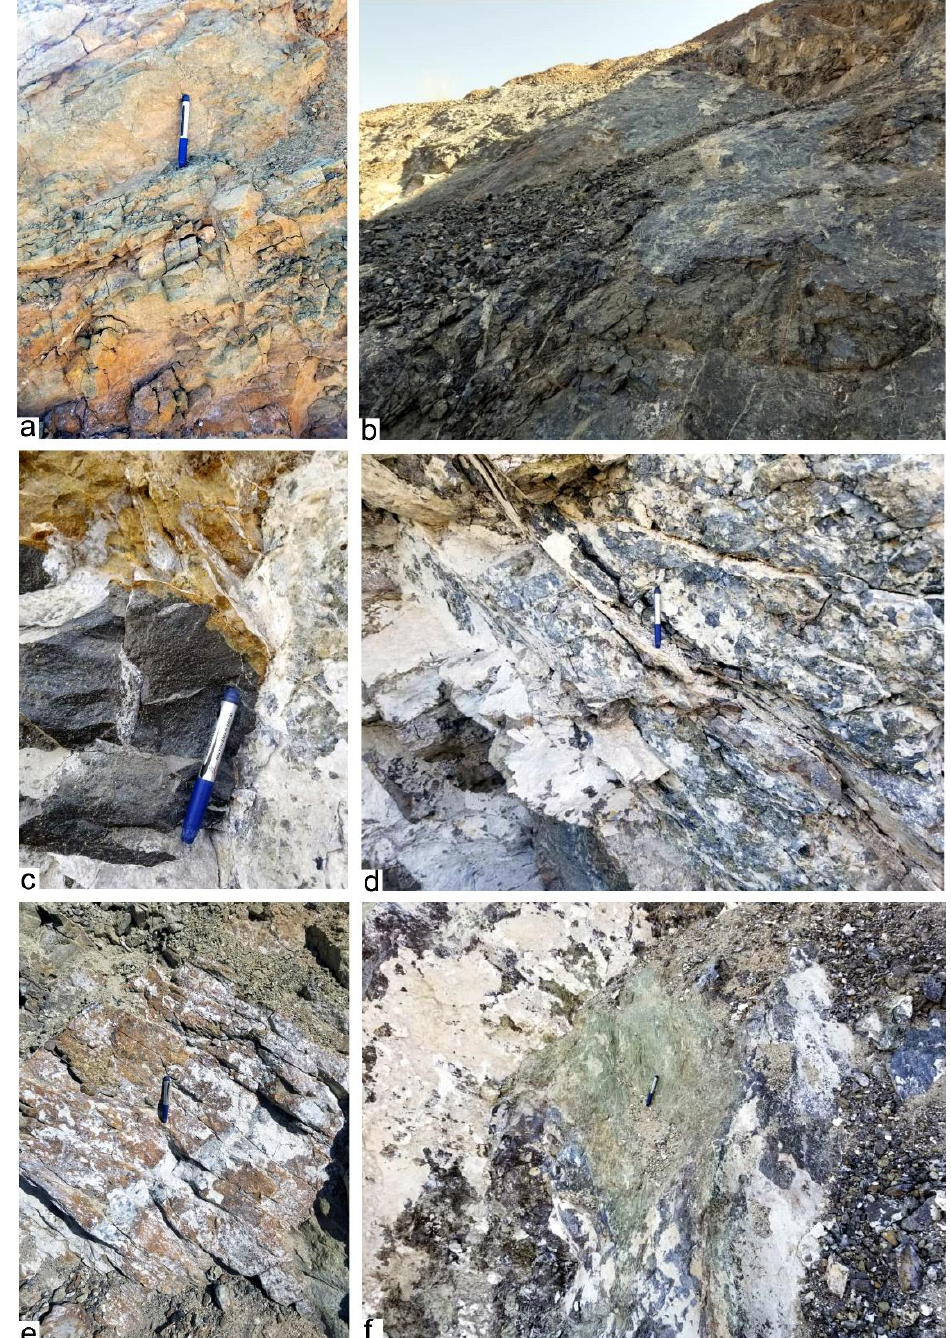
Figure 11. Photographs of ultramafic exposures within the Logar Ophiolite Complex: ( a ) dunite influenced by the fracture arrays, ( b ) contact of dunite (brown) and pyroxenite (grey), ( c ) clear contact between dunite (brown) and pyroxenite (grey) and distribution of carbonates (white) around them, ( d ) serpentinization process of ultramafics represented the outcrops of serpentinite, ( e ) fractured outcrop of serpentinite, and ( f ) serpentinite surrounded by the pyroxenite and influence of carbonates.